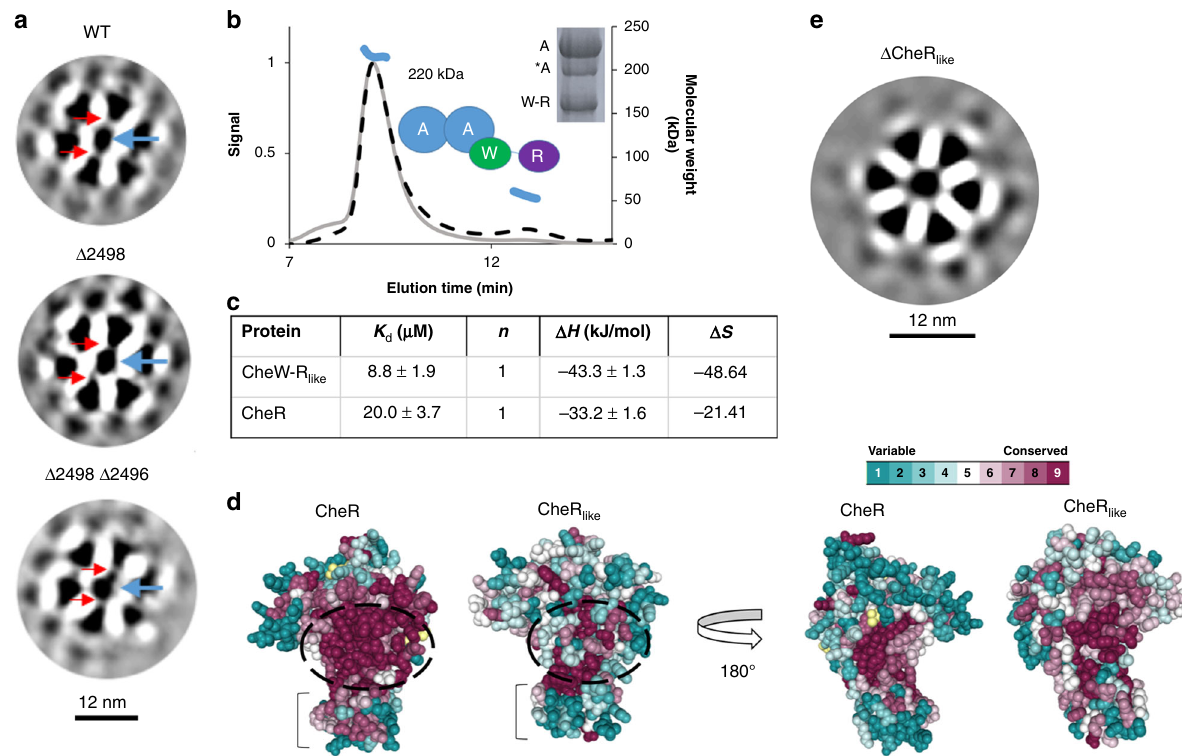
Fig. 4 Investigations into the CheW-CheR like protein. a In Layer 1, the middle density (blue arrow) extends to two positions in the CheA:CheW rings for all three Td strains (red arrows). b SEC-MALS experiments with CheW-R like and CheA demonstrate the presence of a ~220-kDa complex in solution, which is composed of one CheA dimer and one CheW-R subunit. A small amount of unassociated CheW-R like is present. Inset: SDS-PAGE analysis of the elution peak demonstrates the presence of both proteins. A small amount of degraded CheA is also present [*A]. c Thermodynamic binding parameters derived from the microcalorimetric titration of SAM into CheR and CheW-CheR like . Values are reported with 90% con fi dence. d Homology models of Td classical CheR and the CheR like domain from CheW-CheR like were generated and the sequence conservation among F2 homologs were mapped onto the two models. The SAM binding pockets are located in black dashed circles. The sub-domain that binds receptors is indicated with a bracket. Rotating the models by 180° reveals a surface area more highly conserved in CheR like . e Deletion of a CheR-like domain that is covalently attached to the C-terminus of a CheW domain generates sub-tomogram averages with diminished resolution. Source data are provided as a Source Data fi chord in a circle with radius 152 Å. Using the equation h ¼ ffiffiffiffiffiffiffiffiffiffiffiffiffiffiffi p r (cid:2) r 2 (cid:2) L 2 (where h is the height of the circular segment, r is the circle radius, and L is half the chord length (95 Å /2 and 224 Å /2)), the height of the circular segment is 7.6 Å and 49.2 Å, respectively (Fig. S9a, b). Therefore, a single ring and the center of two connected rings (the P3 domain) must bend by an average of 7.6 Å and 49.2 Å toward the cell membrane to accommodate the measured baseplate curvature, respectively.